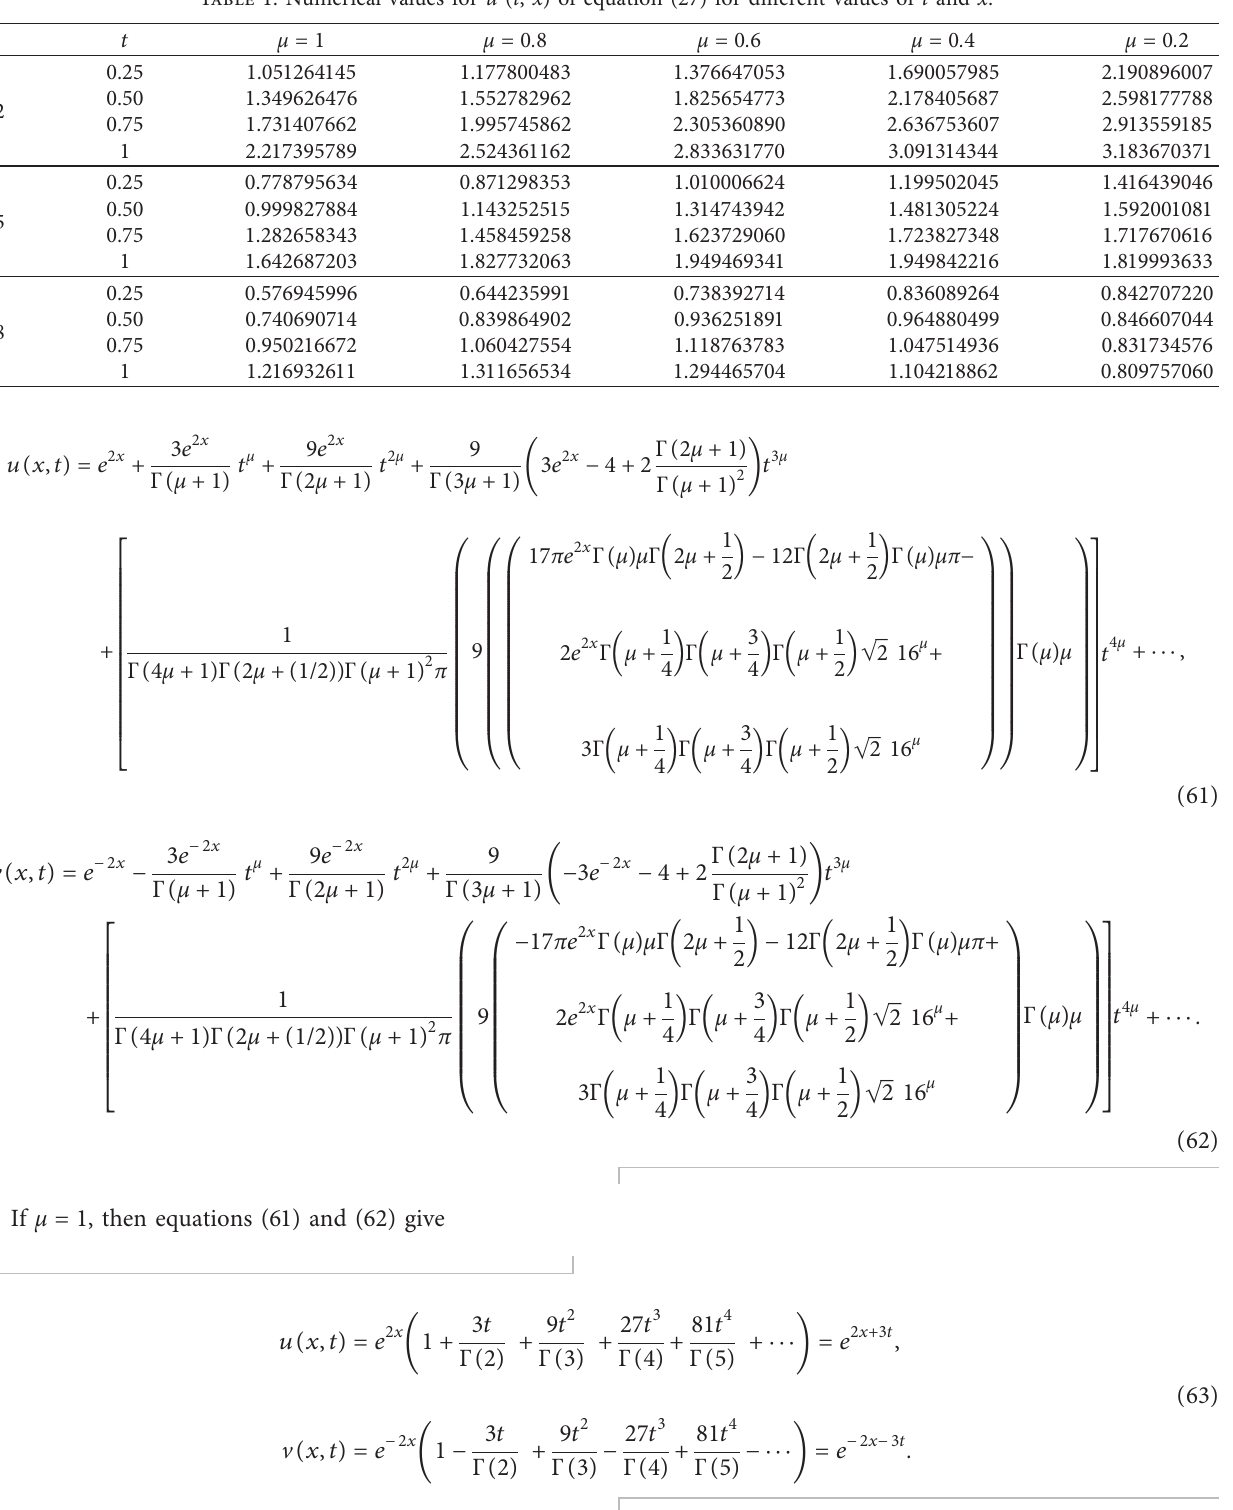
Table 1: Numerical values for u ( t , x ) of equation (27) for different values of t and x